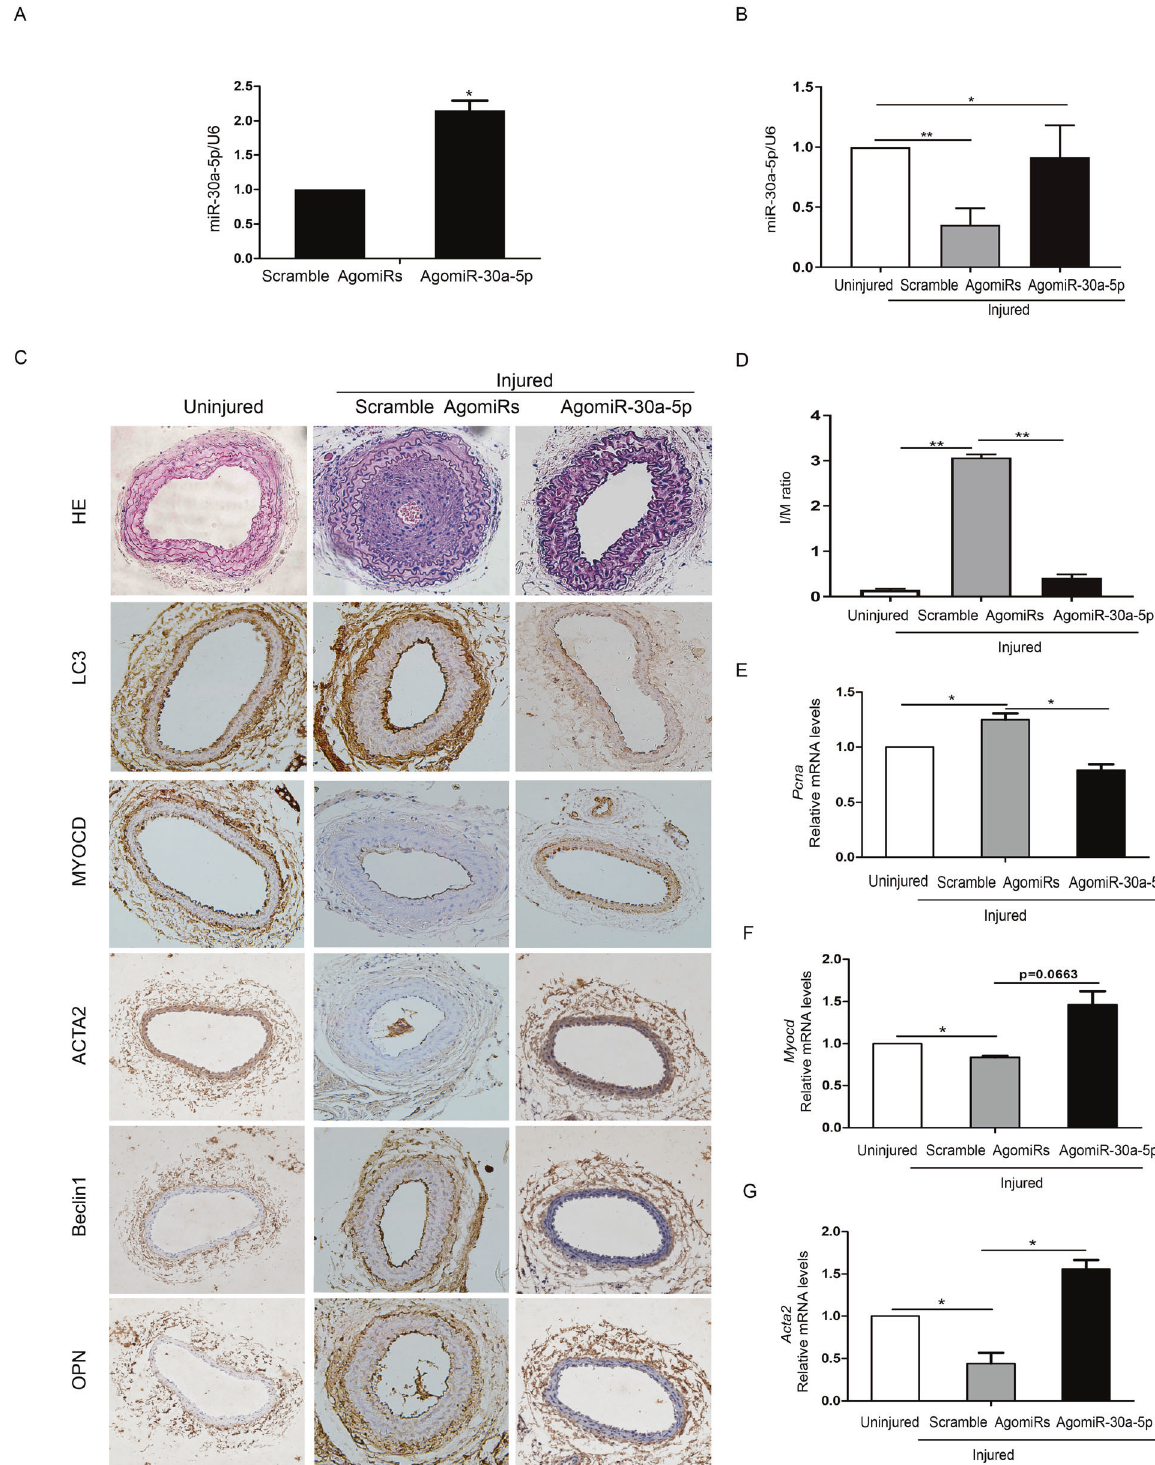
Fig. 7 Restoration of miR-30a-5p in the injured site abolished neointimal formation caused by wire injury of carotid arteries. Wire injury was performed in vivo on mouse carotid arteries, and then local perivascular delivery of miR-30a-5p agomiRs or scramble agomiRs was carried out. A Three days after injury, injured segments of femoral arteries were harvested, and qRT-PCR was performed to con fi rm the overexpression of miR-30a-5p (* P < 0.05, n = 4 – 6). B At 21 days postinjury, injured segments of femoral arteries were harvested and subjected to qRT-PCR to detect the level of miR-30a-5p (* P < 0.05, ** P < 0.01, n = 4 – 6). C Representative images of HE staining and histochemistry staining. D Delivery of miR-30a-5p agomiRs led to a reduction in neointima size and a reduction in the intimato-media ratio (** P < 0.01, n = 4 – 6). The mRNA levels of Pcna ( E ), Myocd ( F ) and Acta2 ( G ) were detected in injured mouse carotid arteries with miR-30a-5p agomiRs or scramble agomiRs by qRT-PCR (* P < 0.05, n = 4 – 6).